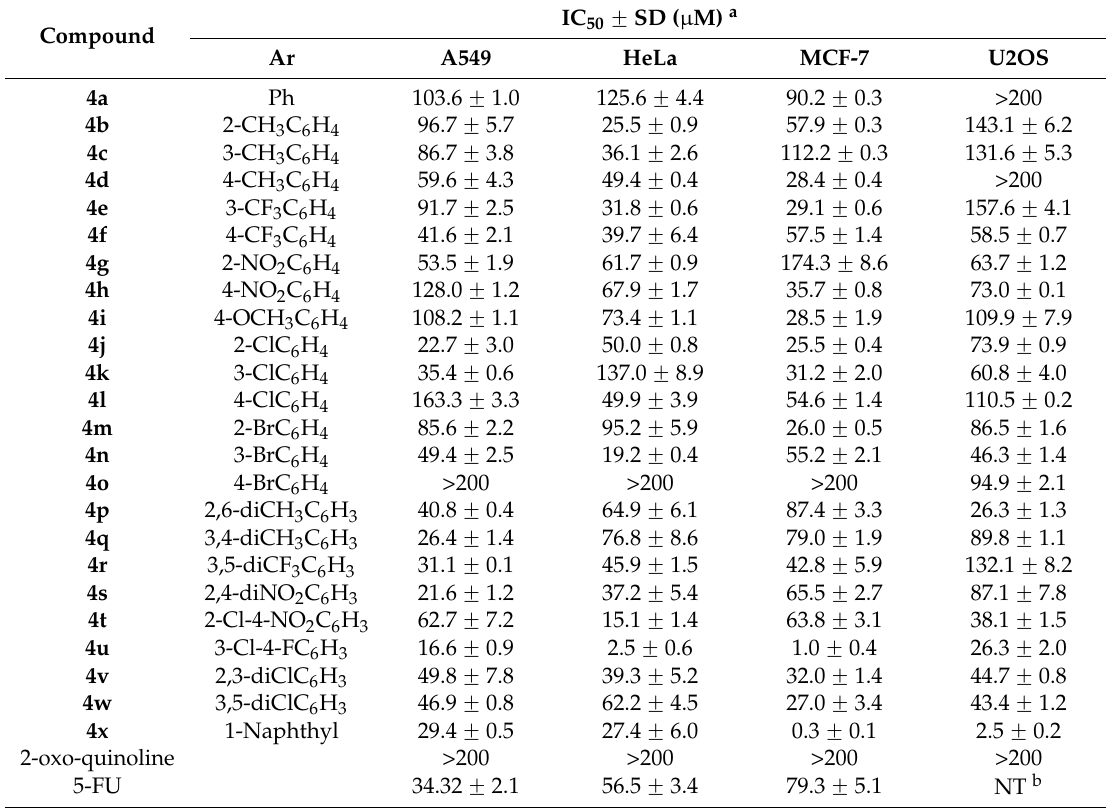
Table 1. Effect of compounds 4a – x against cell viability of different cell lines.